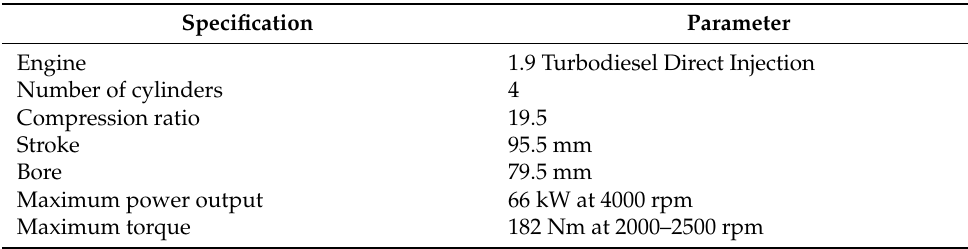
Table 2. Specifications of the engine used in the